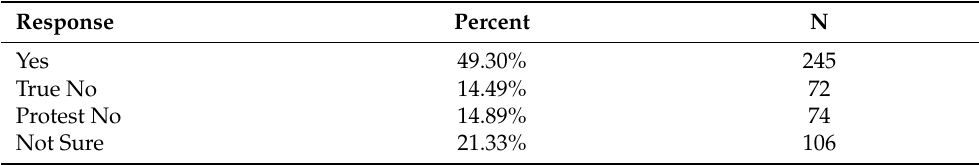
Table 1. Respondent participation results for the smart thermostat